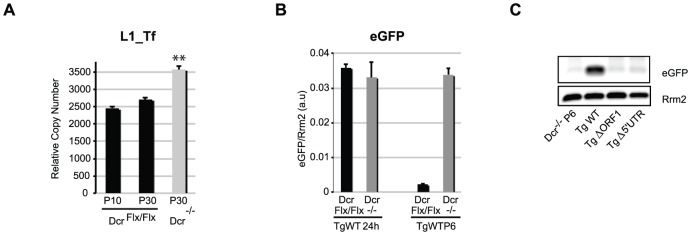
L1 elements retrotranspose in Dcr−/− mESCs.A. qPCR-based copy-number analysis of L1_Tf elements in Dcr
Flx/Flx P10 (5 replicates), P30 (2 replicates) and Dcr
−/− P30 (5 replicates) mESCs. **: p-value<0.01. B. qRT-PCR-based analysis of eGFP mRNA levels in WT and Dcr
−/− mESCs stably transformed with a WT human eGFP-tagged L1 transgene, 24 h post-transfection and 6 passages (P6) after puromycin selection. C. Integrated eGFP as a diagnostic of retrotransposition detected by PCR in the genomic DNA of Dcr
−/− mESCs carrying the human eGFP-tagged L1 transgene after 6 passages post-puromycin treatment.